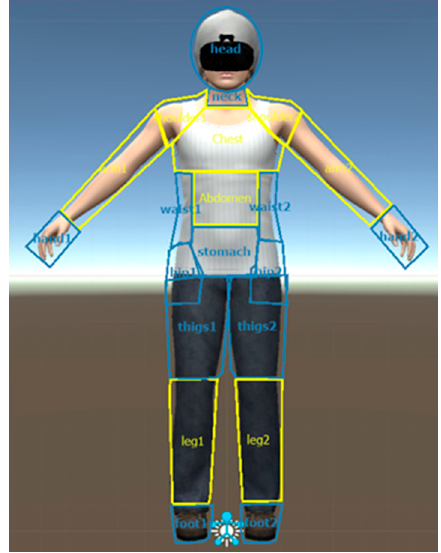
Figure 1. Muscle-related and nonmuscle-related areas of interest on the male virtual avatar.